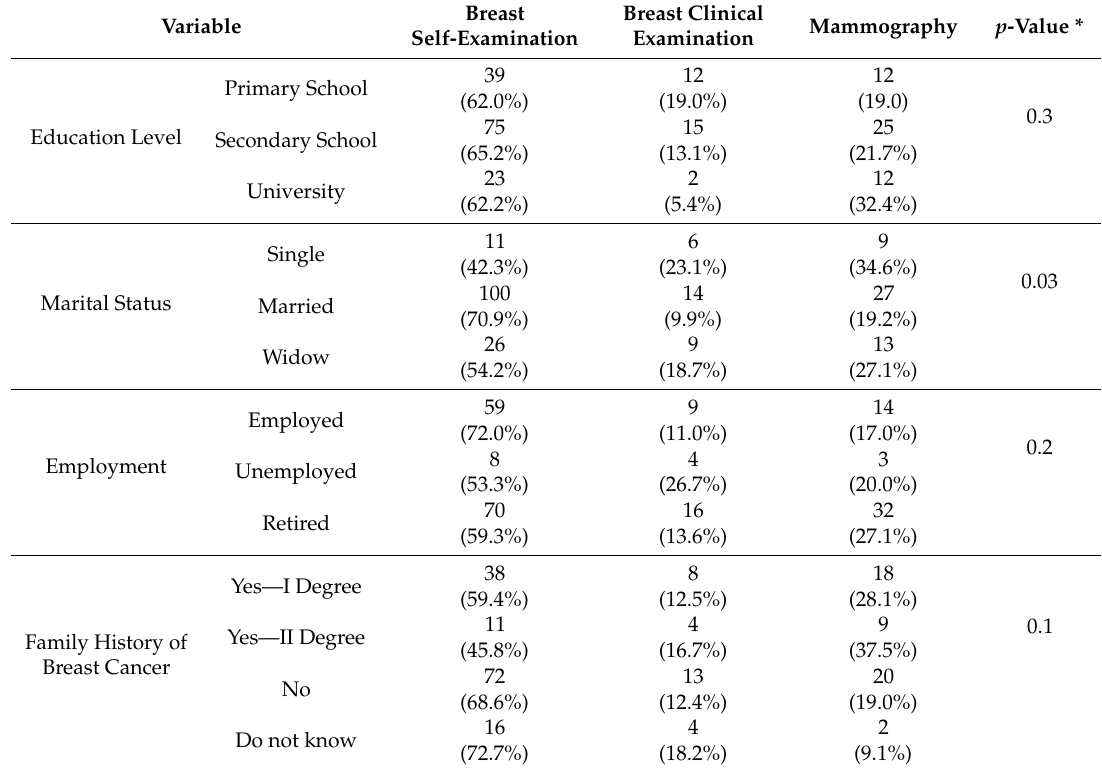
Table 1. Modes of detection of breast cancer suspected changes according to the education level, employment and marital status, and family history of breast cancer, at the age of diagnosis.